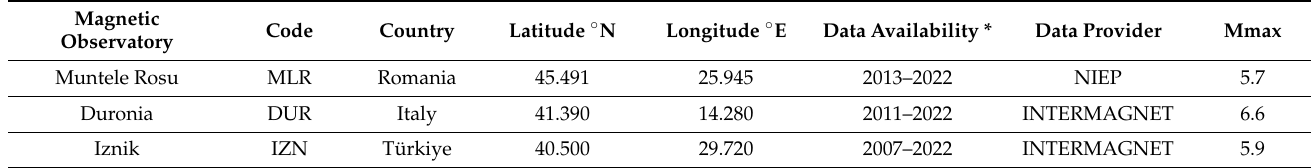
Table 1. Geomagnetic observatories used for the proof of